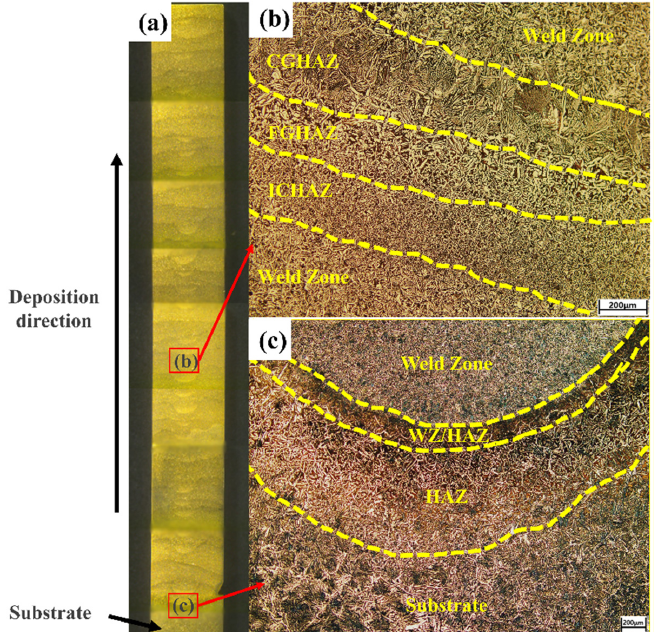
Figure 7. Microstructure morphology in cross-section (y-z plane) of as-fabricated components; ( a ) whole profile of the part in cross-section (y-z plane) ( b ) the middle region; ( c ) the bottom region.